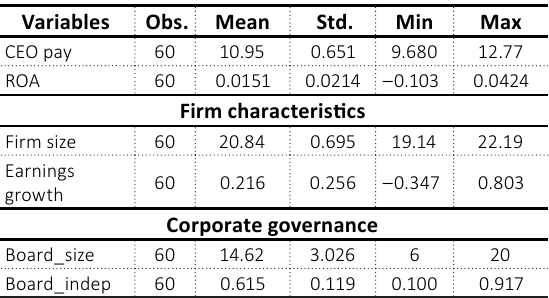
Table 1. Statistics